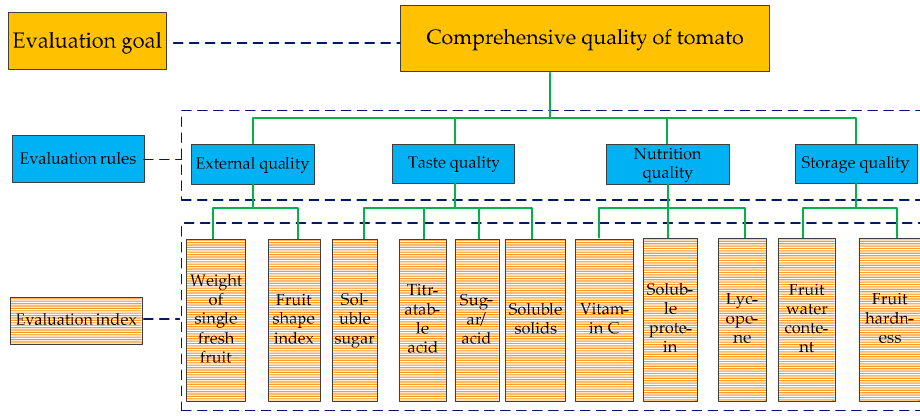
Figure 3. Evaluation system of comprehensive tomato fruit